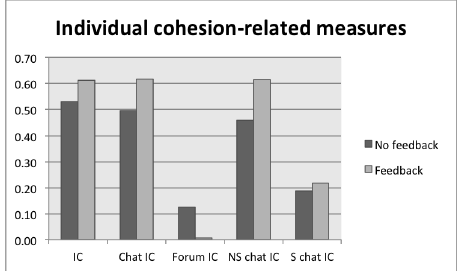
Figure 6. Comparison of Feedback and No-Feedback teams on Individual Cohesion (IC) -related